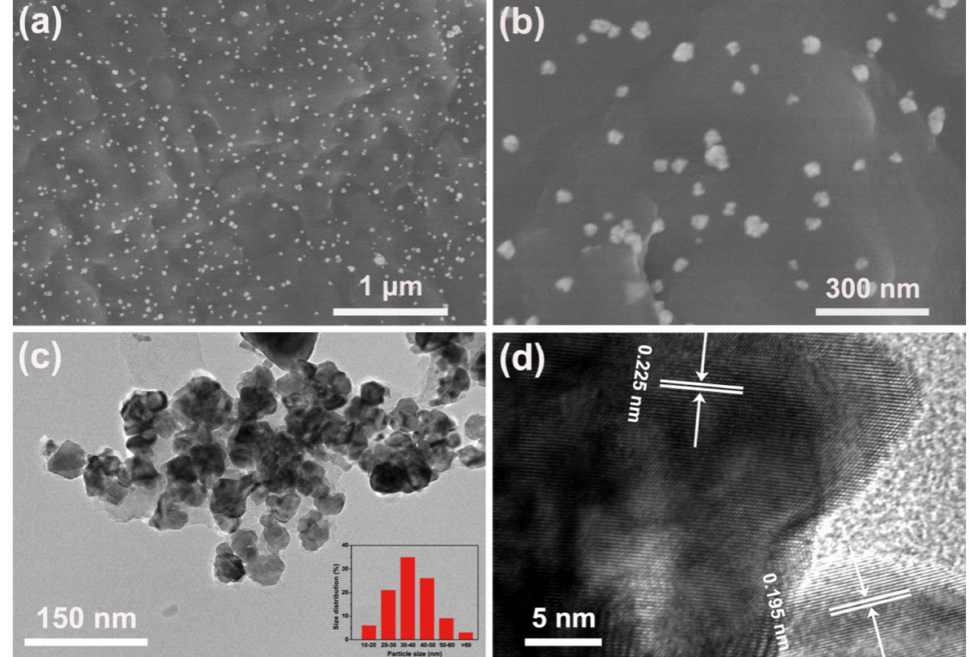
Figure 3. ( a ) Low-magnification SEM image, ( b ) high-magnification SEM image, ( c ) transmission electron microscope (TEM) image and ( d ) high-resolution TEM (HRTEM) image of Pd particles electrodeposited at − 0.15 mA cm − 2 for 2700 s and then treated by the square-wave potential of 10 Hz for 4 h and followed by 90 Hz for 1 h between 0.6 V and –3.2 V in 1 M H 2 SO 4 (Pds −